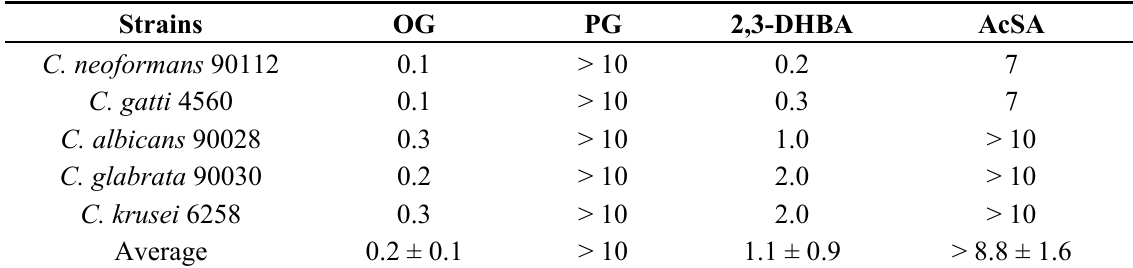
Table 4. MIC (mM) of four phenolic compounds tested in this study: agar plate-based yeast dilution bioassays a .